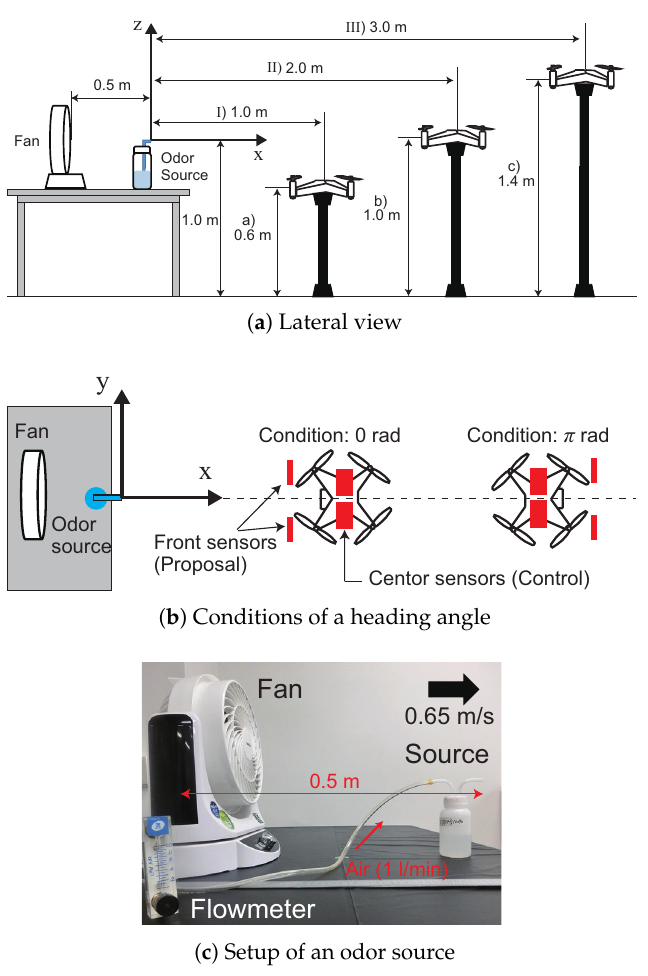
Figure 13. Experimental setup of directional